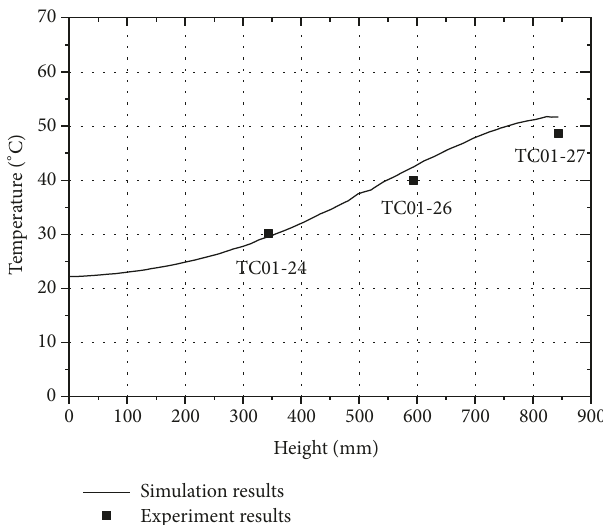
Figure 21: The temperature contrast of simulation and experiment at the support front plate in Test TS1.